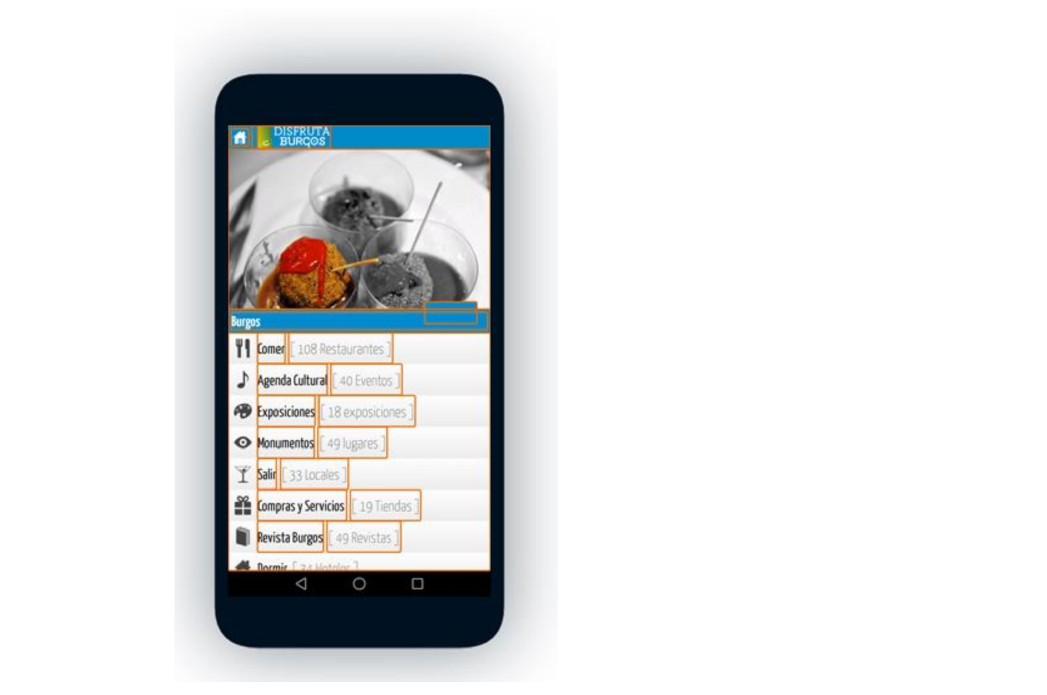
Figure A2. Example of the accessibility analysis of the official Burgos app using Google ´ s Accessibil- ity Scanner [41]. Source: own